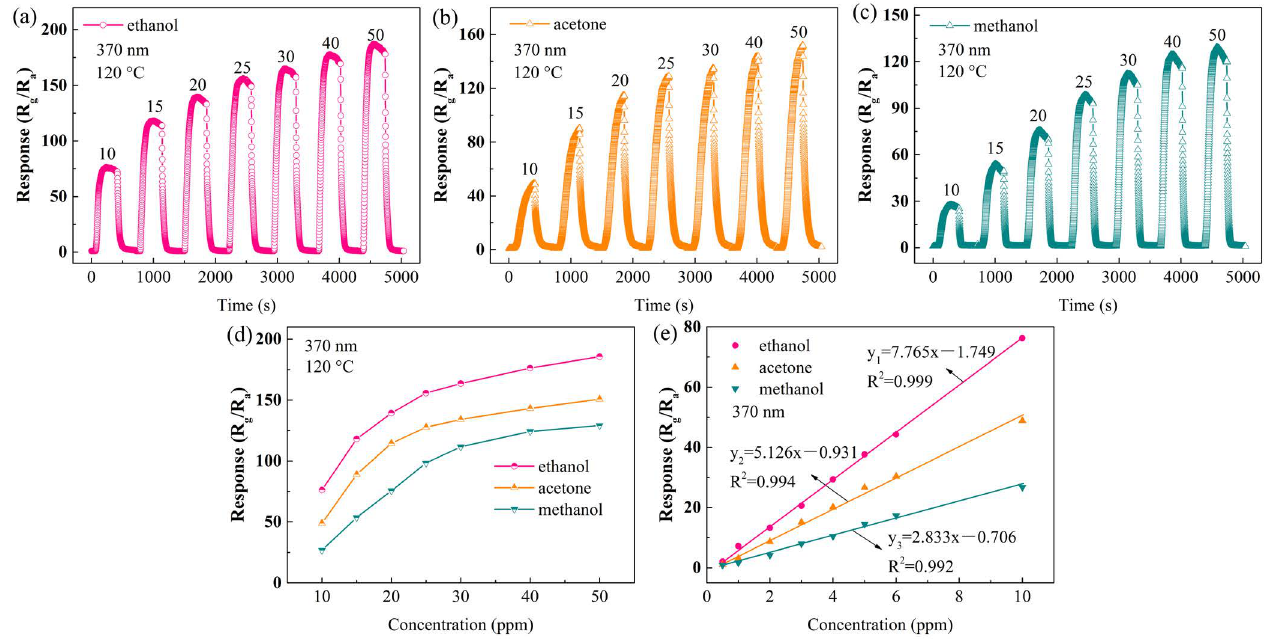
Figure 10. The dynamic-response curve of the SmFeO 3 /YFeO 3 (0.4:0.6) sensor to ( a ) ethanol, ( b ) acetone, and ( c ) methanol gases with different gas concentrations; ( d ) change curves of the SmFeO 3 /YFeO 3 (0.4:0.6) sensor’s response with concentration at 120 °C; ( e ) the linear-fit curves of the gas responses for SmFeO 3 /YFeO 3 (0.4:0.6) sensor.